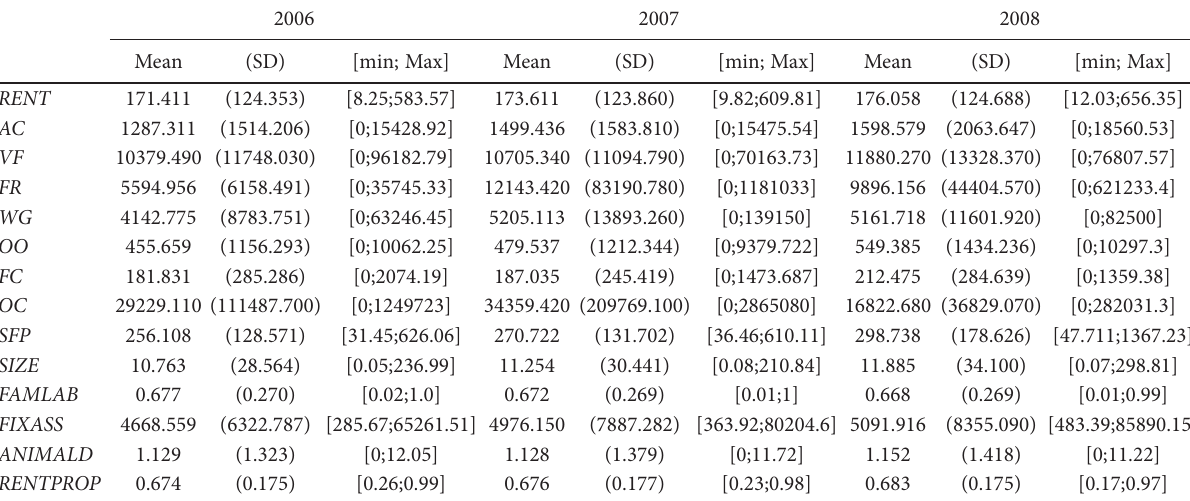
Table 2. Summary statistics of the variables.